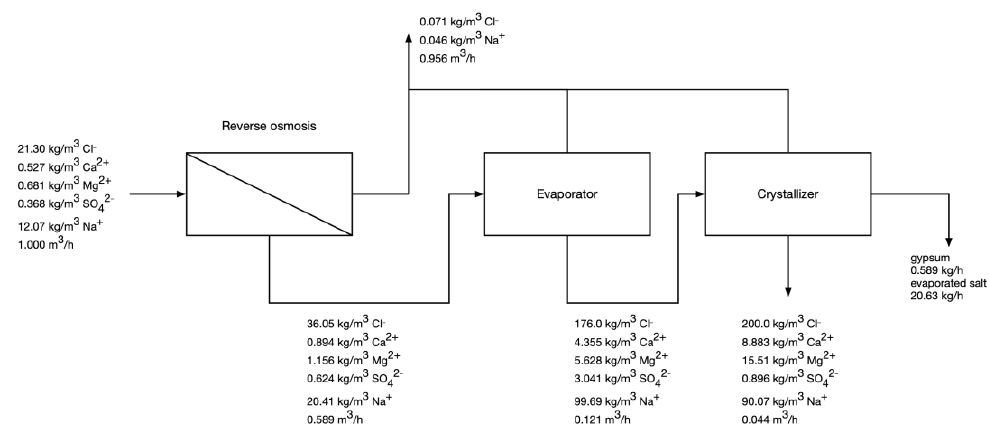
Figure 3. Calculated compositions of process streams in RO-evaporator-crystallizer if no NF pre- treatment is used.